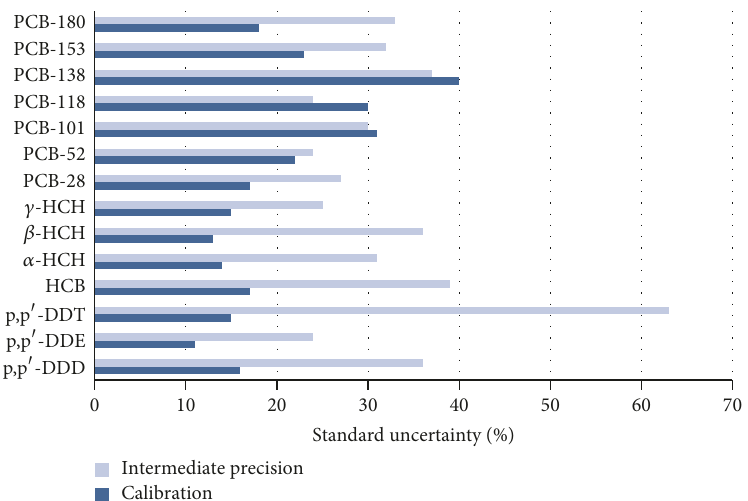
Figure 4: Standard uncertainty for intermediate precision and calibration contributions for the analysis of selected pesticides and PCBs in sediments.